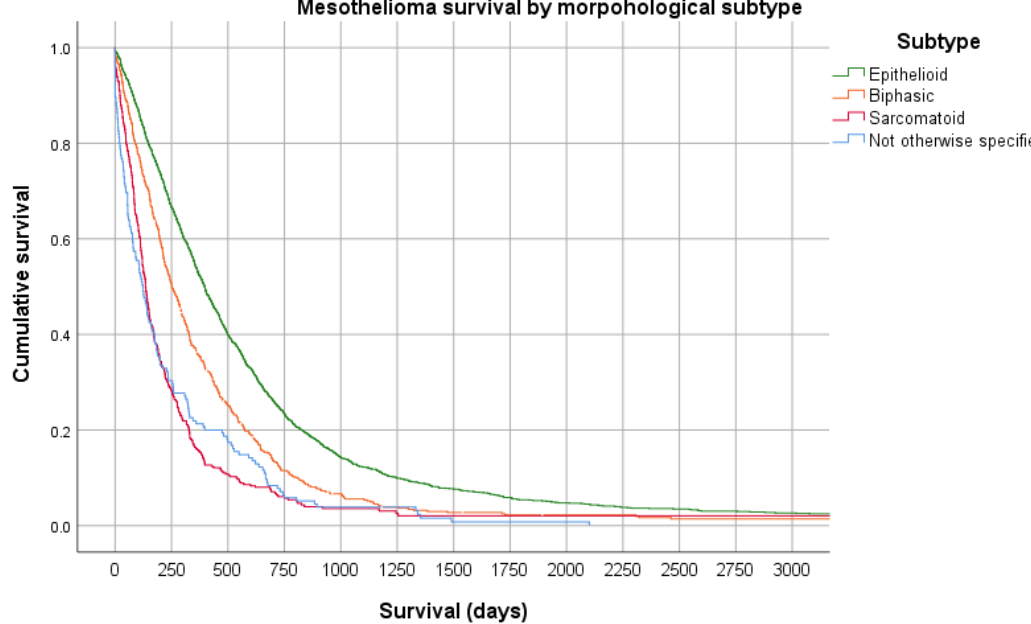
Figure 2. Kaplan Meier survival curve of 2796 cases of mesothelioma from the Western Australia Mesothelioma Registry stratified by morphological subtype demonstrating a significant difference in overall survival between subtypes (Log Rank p < 0.0001).